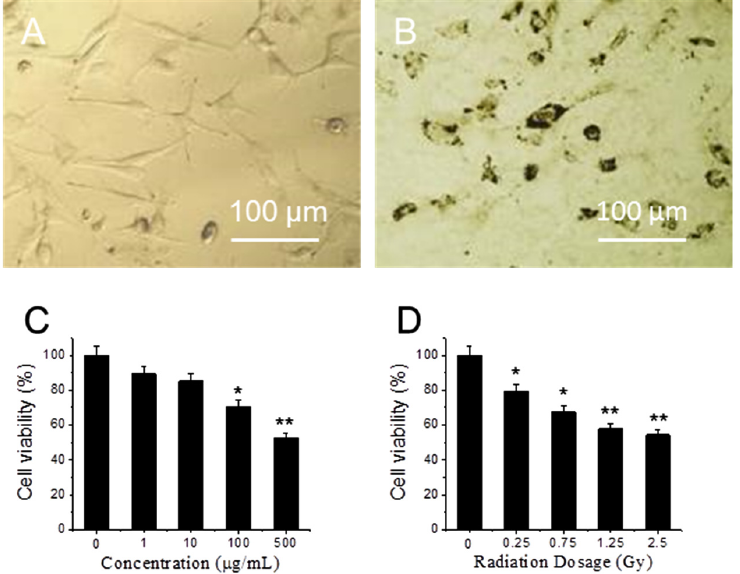
Figure 1. Optical images of cells ( A ) and cells treated with graphene oxide (GO) for 24 h ( B ); cytotoxicity of cells treated with different concentrations of GO ( C ); and exposed to different dose of X-ray ( D ). “ * ” ( p < 0.05) and “ ** ” ( p < 0.01) represent significant difference and extra significant difference,